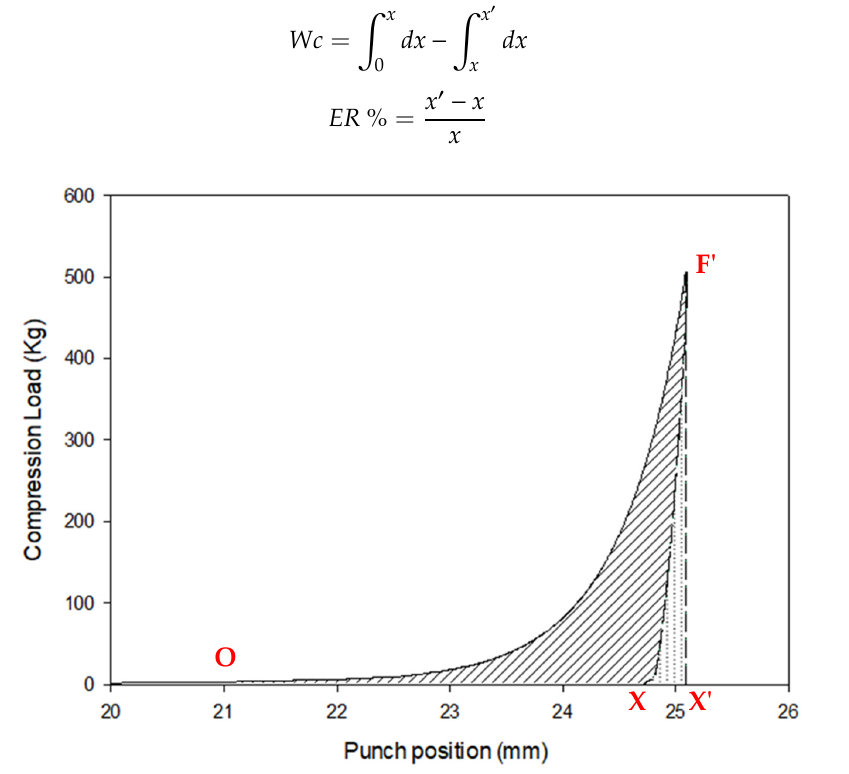
Figure 1. Representative force—displacement profiles recorded during compression and decompression.